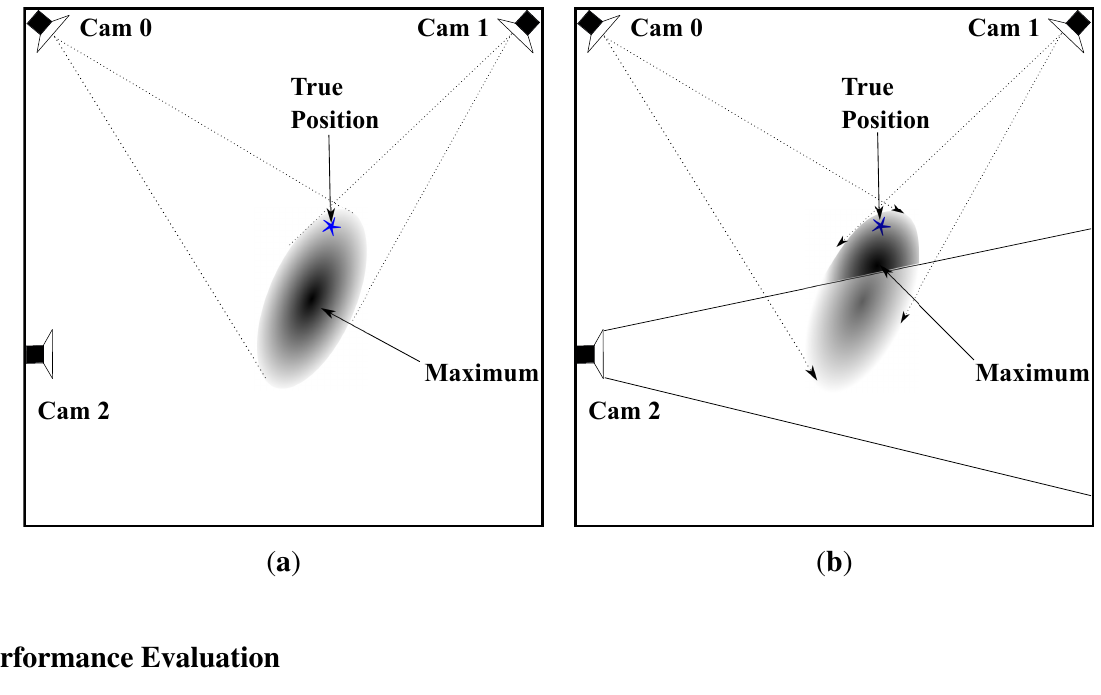
Figure 5. Joint likelihood computed using ( a ) camera 0 and 1; ( b ) camera 0, 1 and 2. Darker color indicates higher